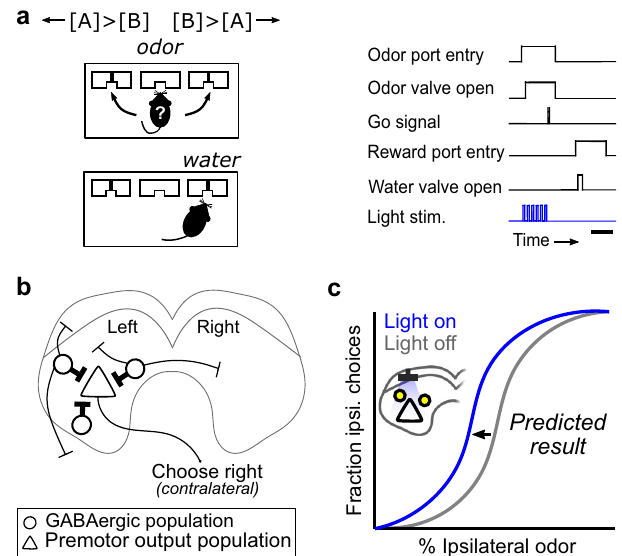
Fig. 1 Expected functional role for GABAergic SC neurons in a left-vs- right spatial choice task. a Spatial choice task. Reward location (left or right) was determined by the relative concentrations of Odors A and B [( + )-carvone and ( − )-carvone, respectively]. In each trial, the mouse entered the central odor port, chose a reward port while sampling an odor mixture, waited for the go signal, executed its choice, and received water if correct. To test their functional role in spatial choice, GABAergic SC neurons were unilaterally photoactivated during odor sampling on 30% of trials. Scale bar, ~500 ms. b GABAergic SC neurons project within one SC, between the SCs and to extracollicular targets. We hypothesized that, during spatial choice, GABAergic SC neurons suppress premotor output activity that promotes rightward (i.e., contralateral) choices. Thicker lines represent higher hypothesized activity during spatial choice. External inputs to the SC are omitted for simplicity. c We predicted that photoactivation of GABAergic SC neurons during choice would bias choices ipsilateral to the photoactivated side, indicated by a leftward shift in the psychometric function on light-on trials (blue) compared to light-off trials